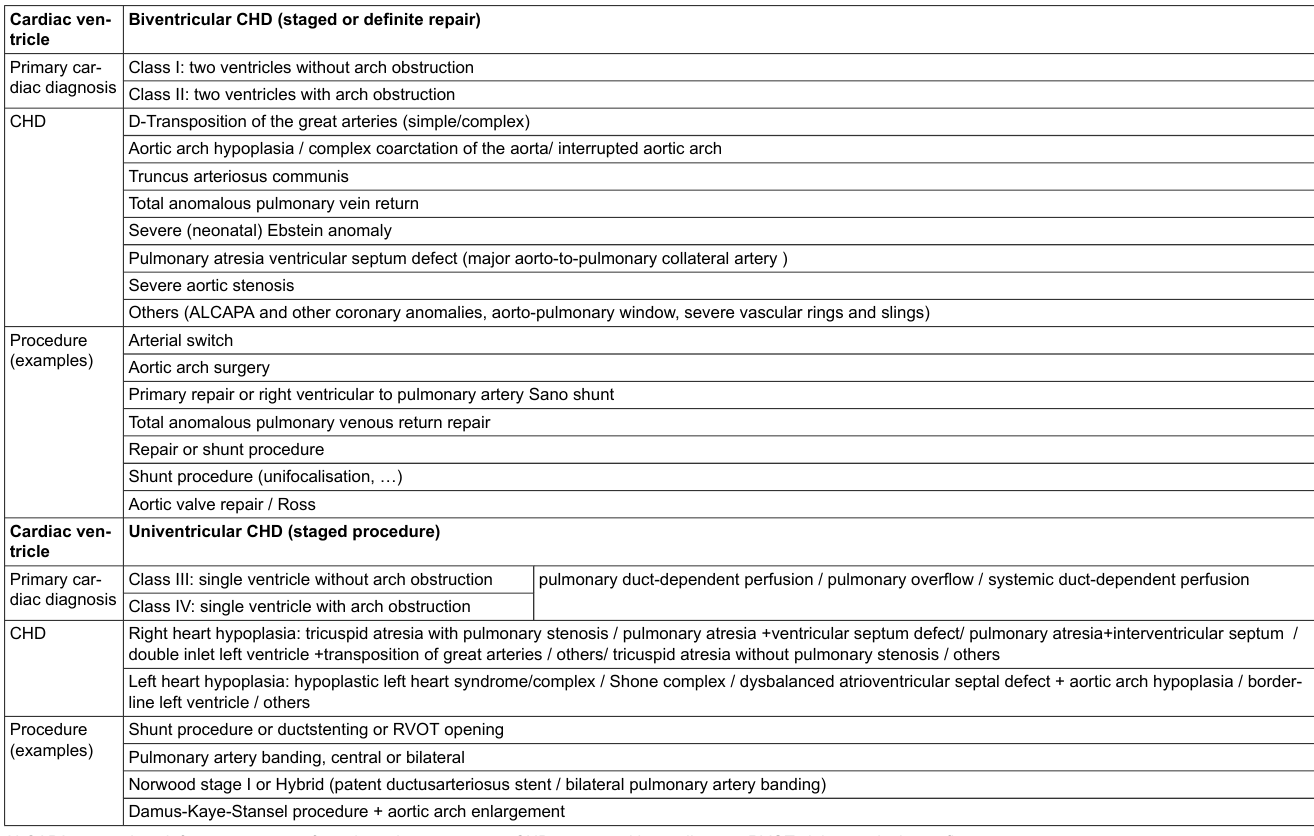
Table 1: Cardiac diagnostic criteria for patients included in the ORCHID registry. Cardiac ven-